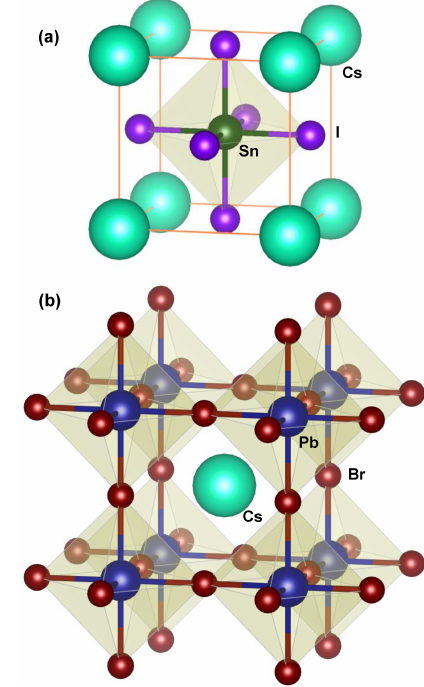
Figure 19: Calculated X-ray diffraction patterns of CH 3 NH 3 PbBr 3 , CH 3 NH 3 PbCl 3 and CH 3 NH 3 SnCl 3 with cubic structures.